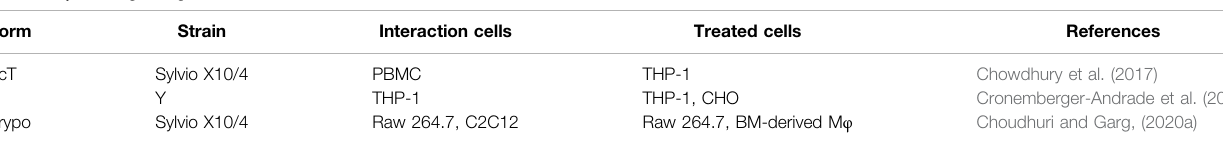
TABLE 3 | EVs originating from infected cells.